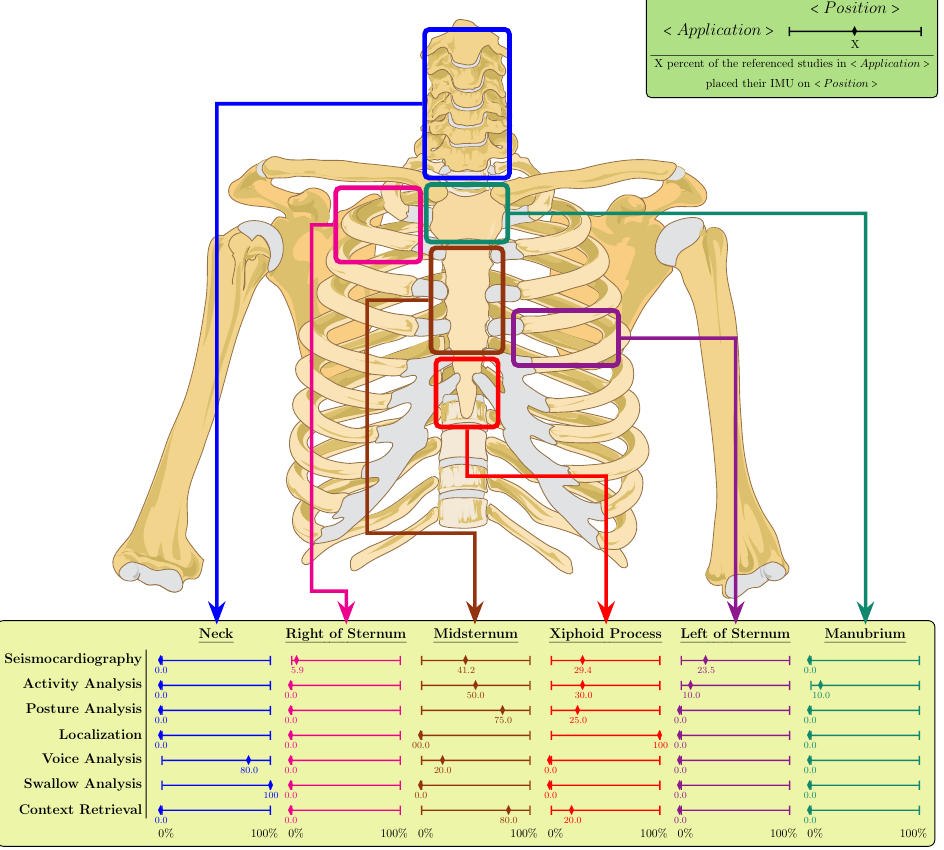
Figure 3. Distribution of the IMUs on chest per application area based on the referenced studies. The percentages are calculated to represent the ratio of the referenced studies in an application area that rely on a specific body site in proportion to the total referenced studies of that application